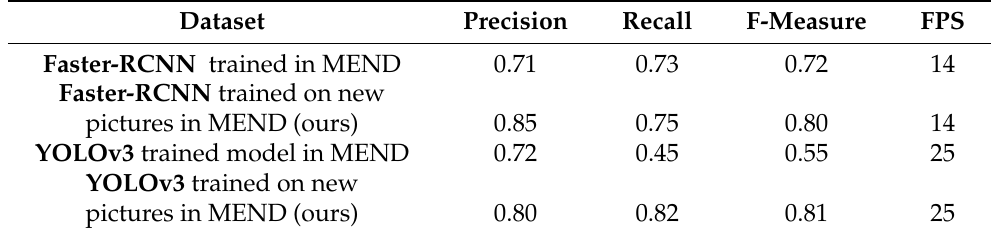
Table 6. Comparative experiment: Faster RCNN and YOLOv3. As a comparison for text detection in complex environments, experiments were conducted using Faster-RCNN and YOLOv3. First, training was performed on the extraction of features of industrial nameplates separately, and then fine-tuning was carried out on the generated data according to the strategy. The results show that both methods achieved a slight improvement. Dataset